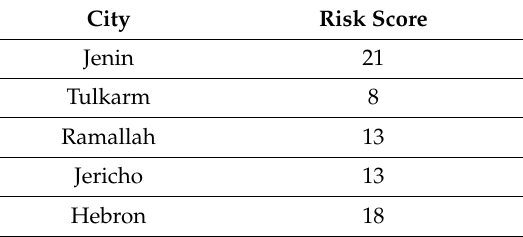
Table 20. Risk score for the water services